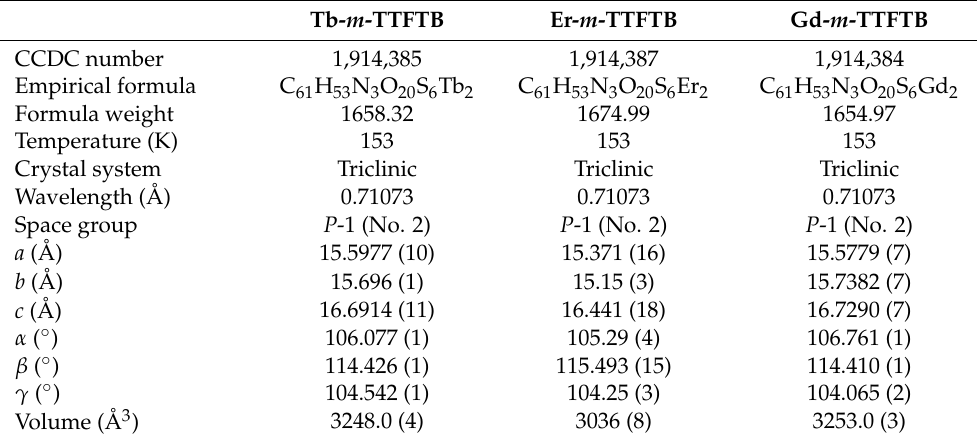
Figure 1. Structure of Tb- m -TTFTB ([Tb 2 ( m -TTFTB)( m -H 2 TTFTB) 0.5 (HCOO)(DMF)] · 2DMF · 3H 2 O): the coordination environments of Tb1 ( a ) and Tb2 ( b ); a one-dimensional chain in Tb- m -TTFTB ( c ); ( d ) view of the three-dimensional framework along the [111] direction; ( e ) the two-dimensional structure assembled by the 1D chains and m -TTFTB 4 − ligands; ( f ) the weak interaction between adjacent TTF linkers. Some of the m -TTFTB 4 − ligands are simplified to benzoate group for clarity. Crystal and structure refinement parameters for Tb- m -TTFTB, Er- m -TTFTB, and Gd- m